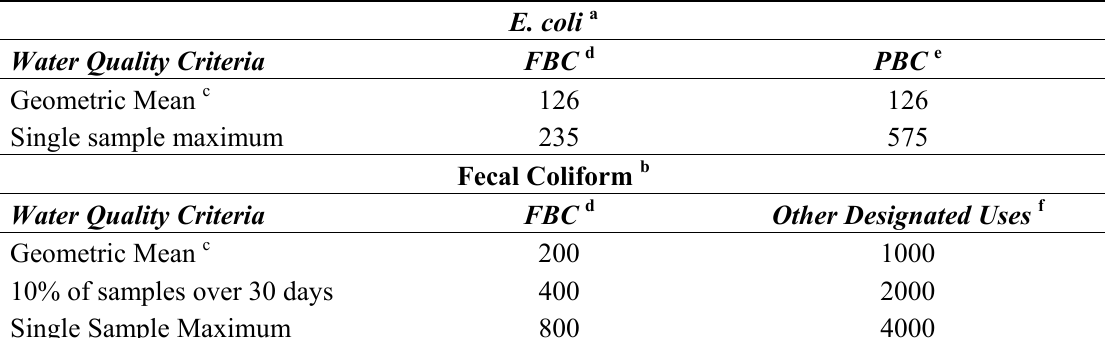
Table 1. Water quality standards for E. coli and fecal coliforms. Units are colony forming units (cfu)/100